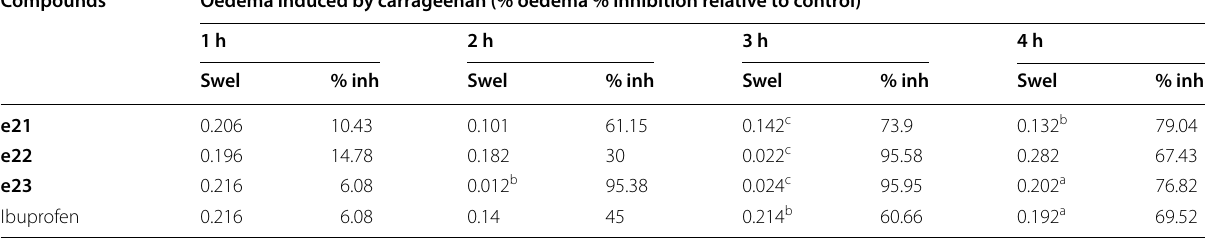
Table 42 In vivo anti-inflammatory